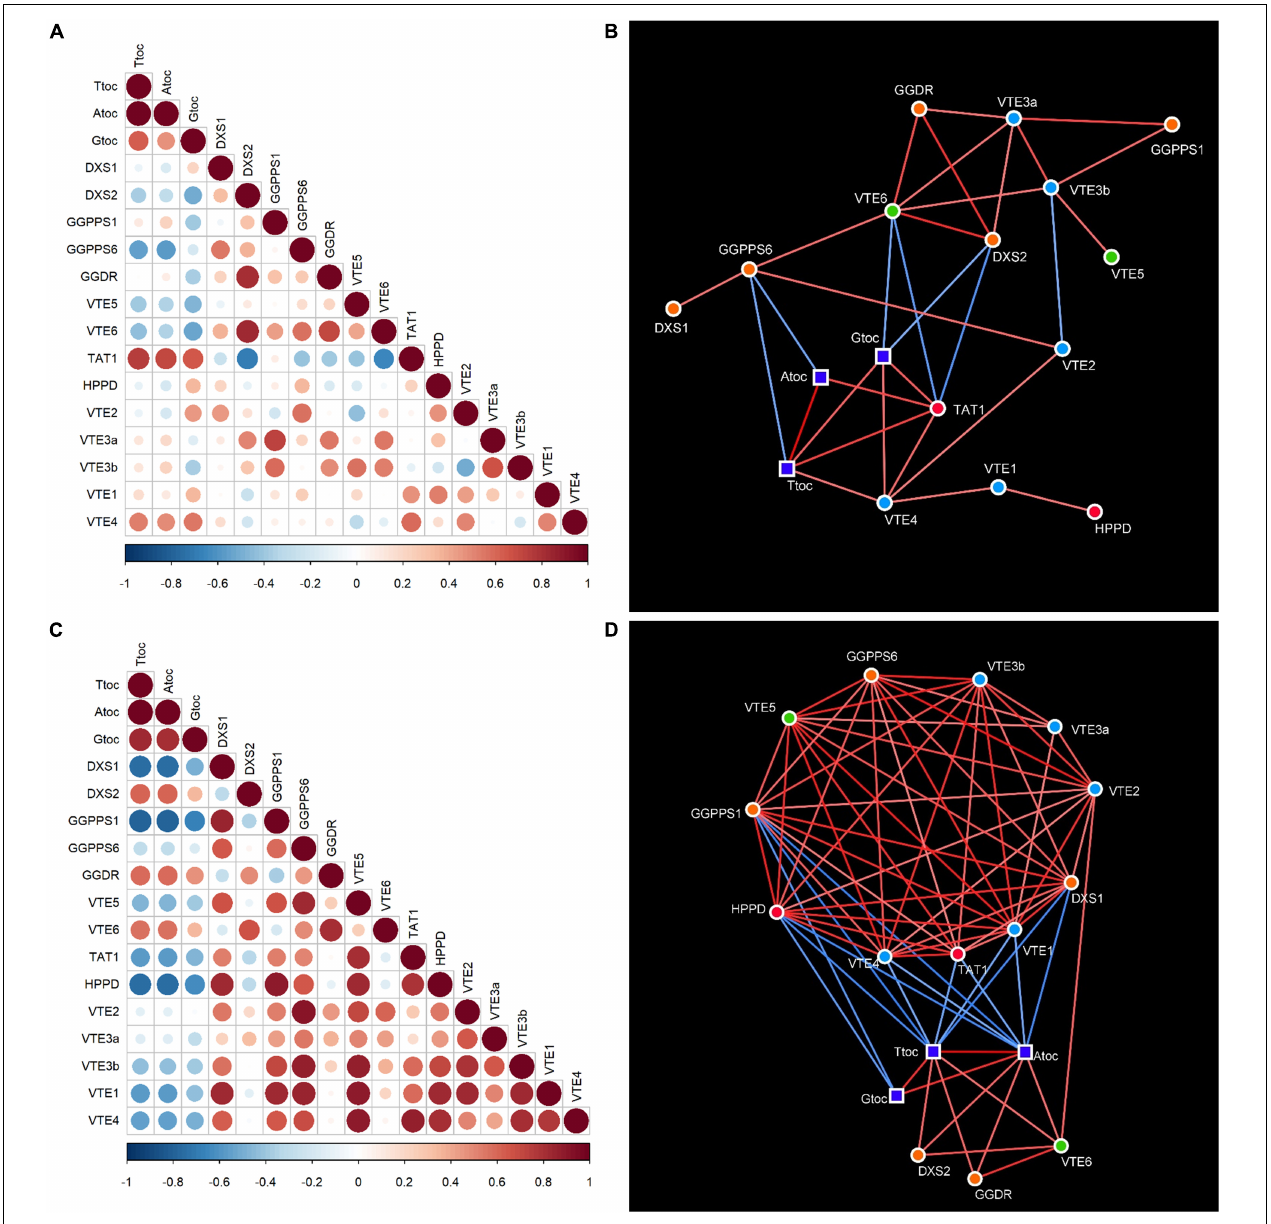
FIGURE 8 | Correlation matrices (A,C) and networks (B,D) of tocopherol contents and expression of genes involved in tocopherol synthesis in the flavedo (A,B) and pulp (C,D) during fruit maturation of grapefruit ( C. paradisi ), lemon ( C. limon ), sweet orange ( C. sinensis ), and mandarin ( C. clementine ). Positive and negative correlations in the matrices are shown in different shades of red and blue, respectively, with the size of the circle and color intensity indicating the magnitude of Pearson’s correlation coefficient. In the correlation networks, square nodes represent tocopherol contents (Ttoc, total tocopherols; Atoc, α -tocopherol; Gtoc, γ -tocopherol) and circle nodes represent genes (green, genes involved in the recycling of phytol; orange, genes of the MEP pathway; red, genes of the SK pathway; and blue, genes of the tocopherol-core pathway). Lines joining the nodes represent correlations (edges); positive correlations are shown in red, while negative correlations are in blue, and the color intensity represents the strength of the correlation (absolute value of the Pearson’s correlation coefficient). Only significant correlations ( p -value ≤ 0.05) were taken into account for constructing the correlation networks. Values for the correlation coefficients and significances are detailed in Supplementary Tables 7 , 8 , 13 , 14